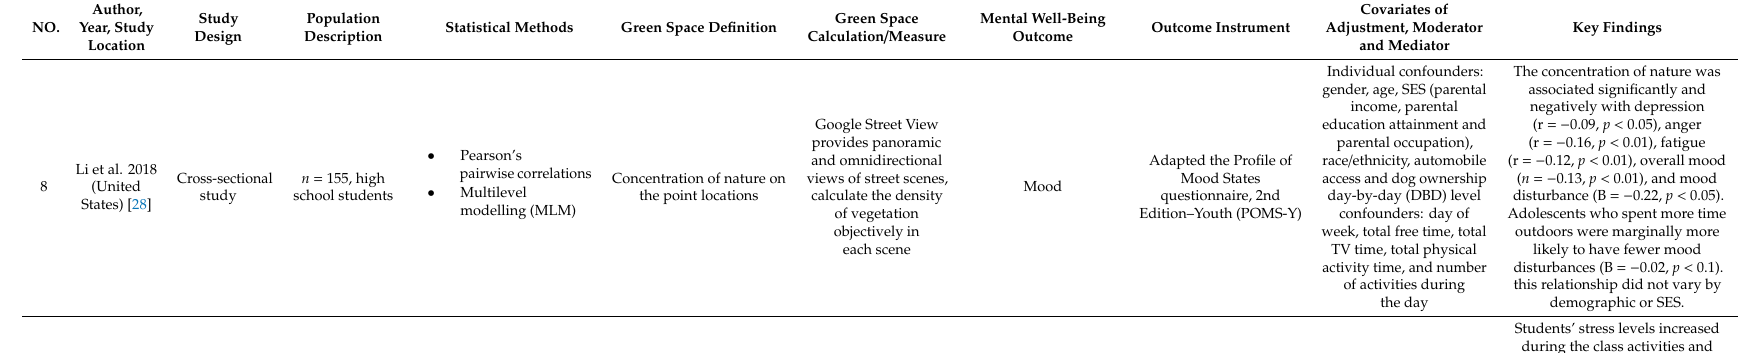
Subjectivestress: Visual AnalogueScale(VAS) Objectivestress: Electrocardiography (EKG),BloodVolume Pulse(BVP),Skin ConductanceLevel(SCL)